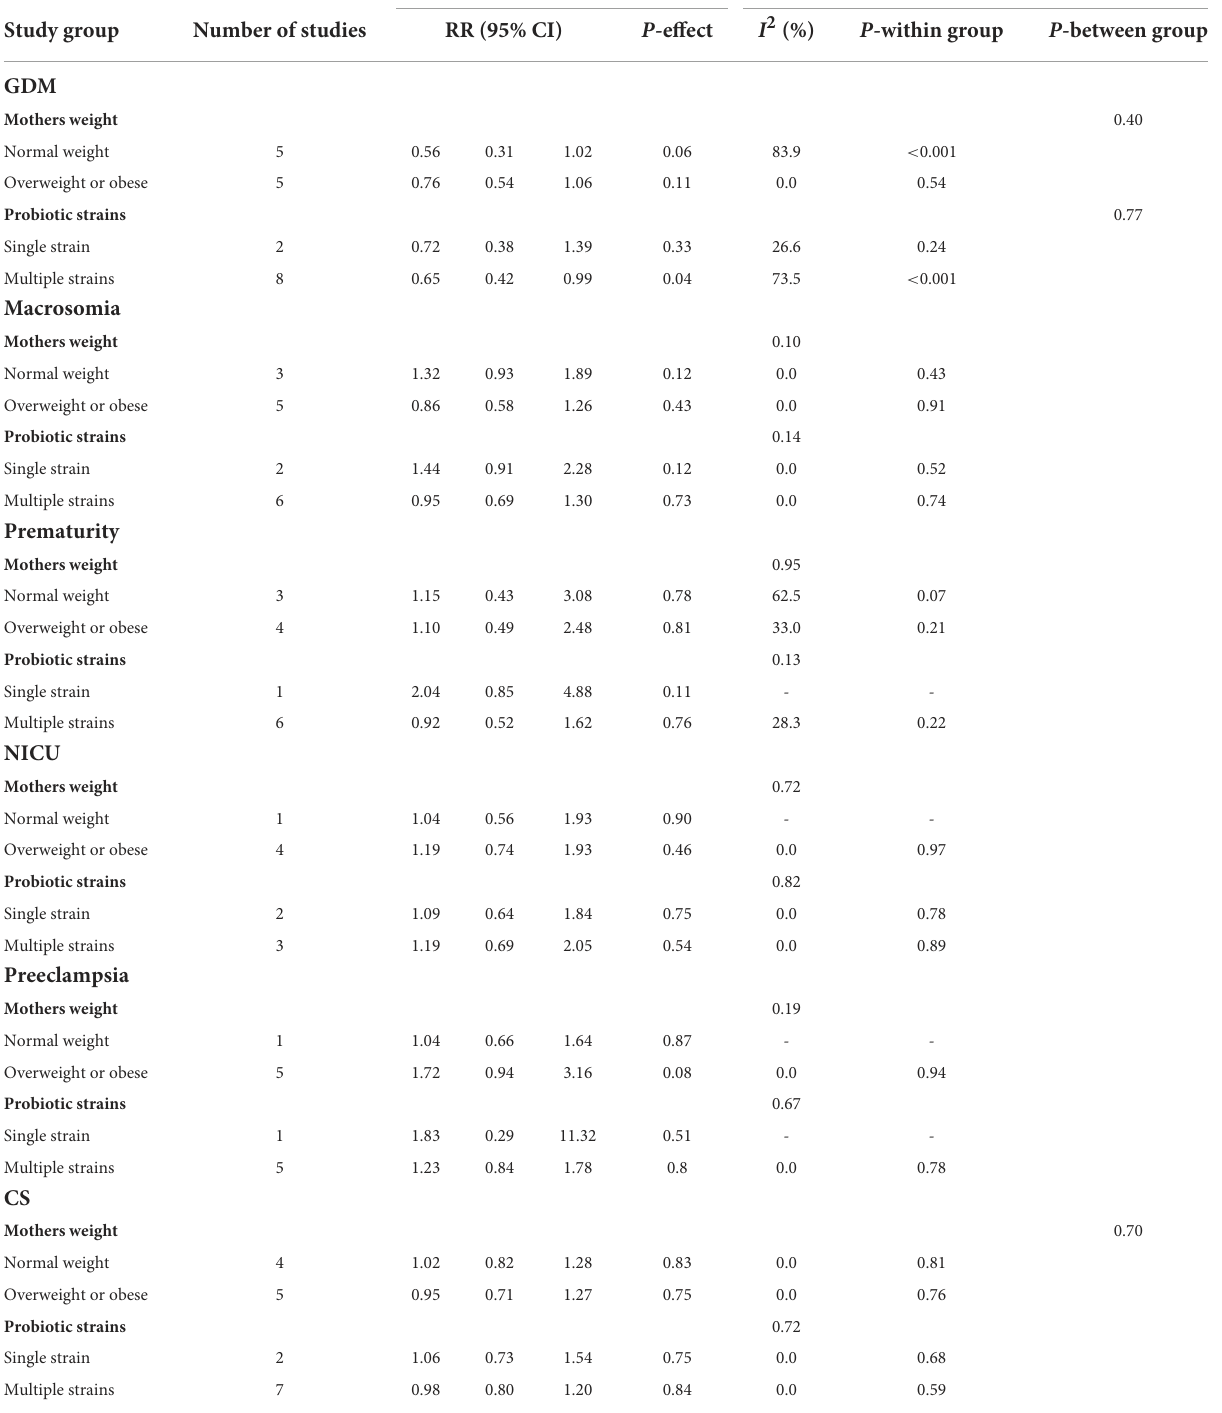
TABLE 2 Results of subgroup-analysis based on mothers’ weight status before pregnancy and number of probiotic strains. Meta-analysis *